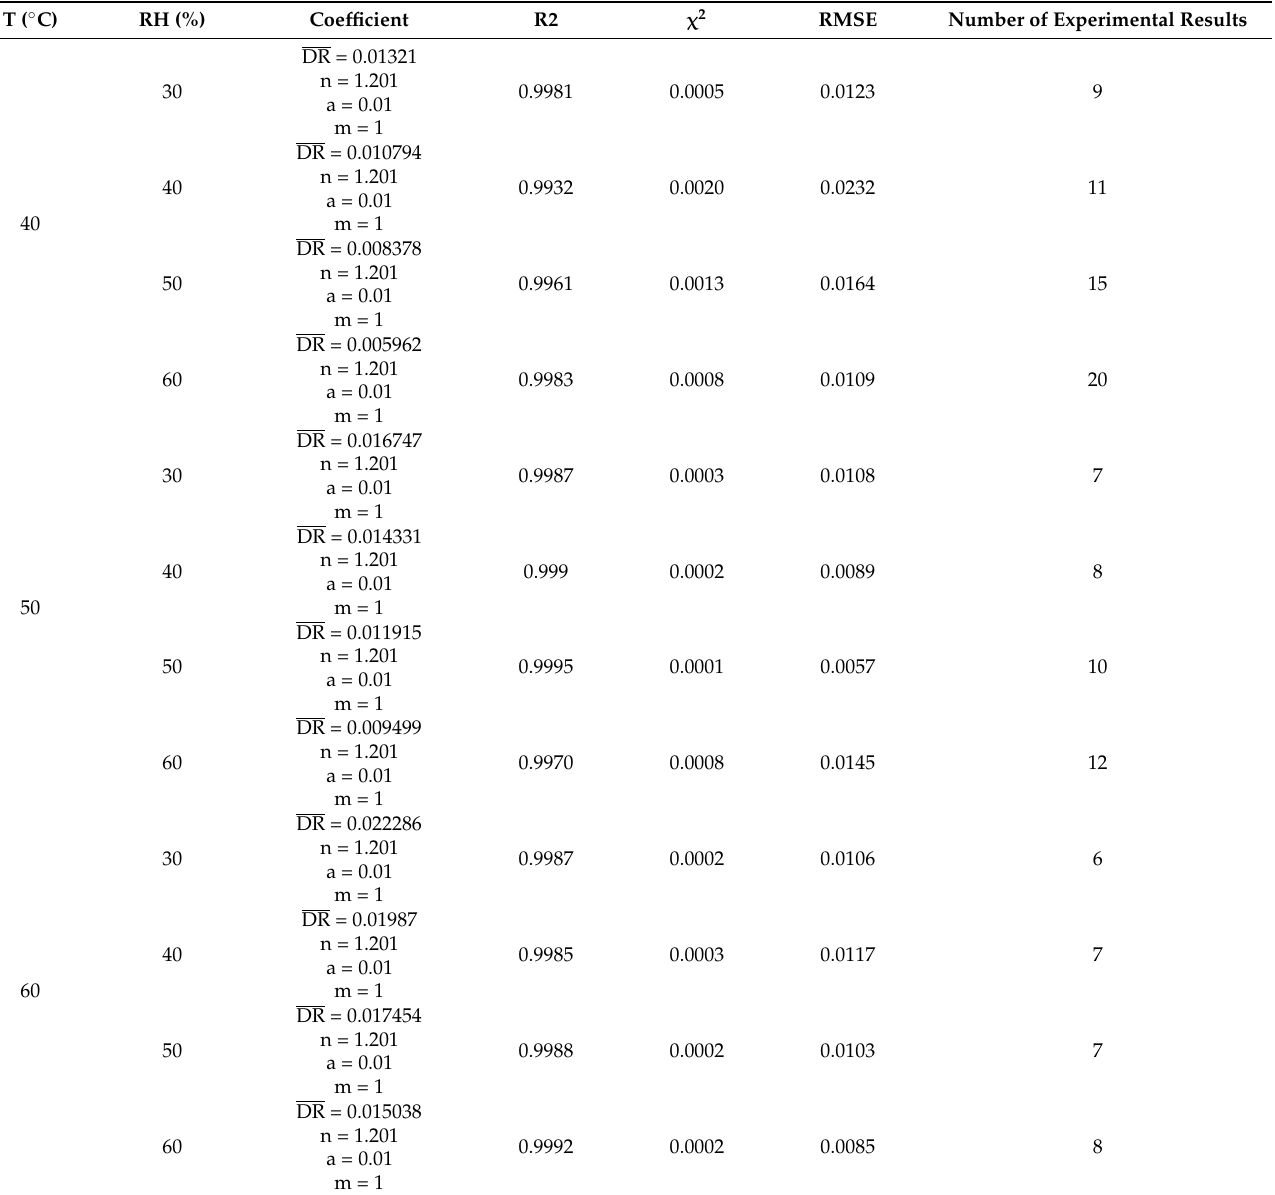
Table 4. Statistical analysis data of the first stage of the new model for sludge